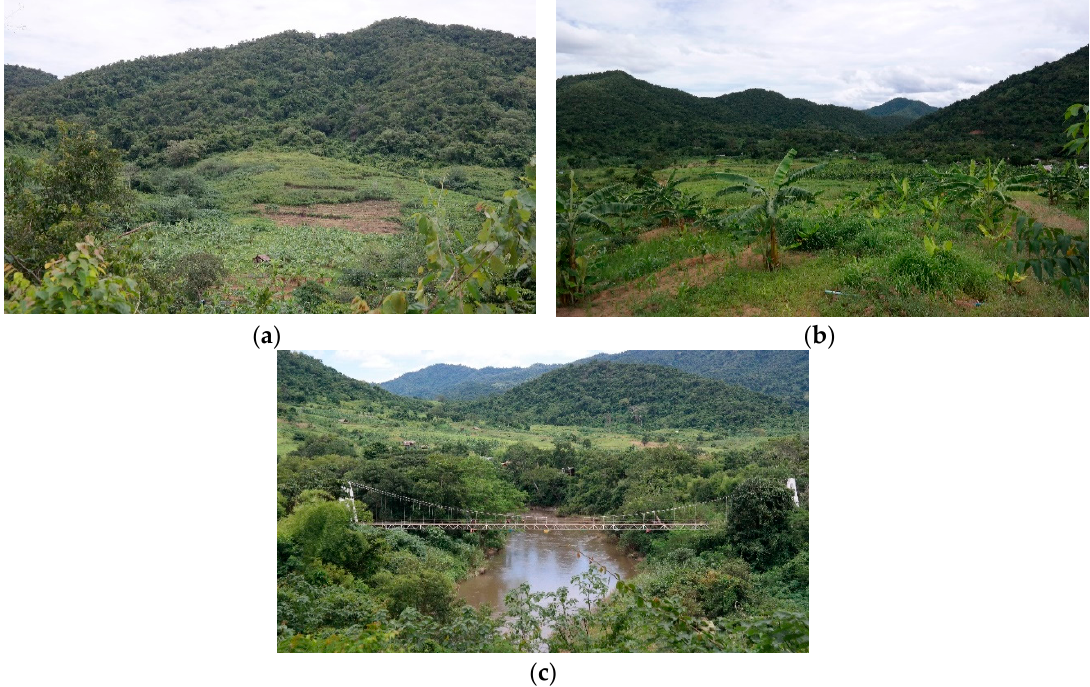
Figure 4. Some details from the two case-study villages (photos by the authors): ( a ) farming on the highland; ( b ) banana crops; ( c ) river bridge (source of water).